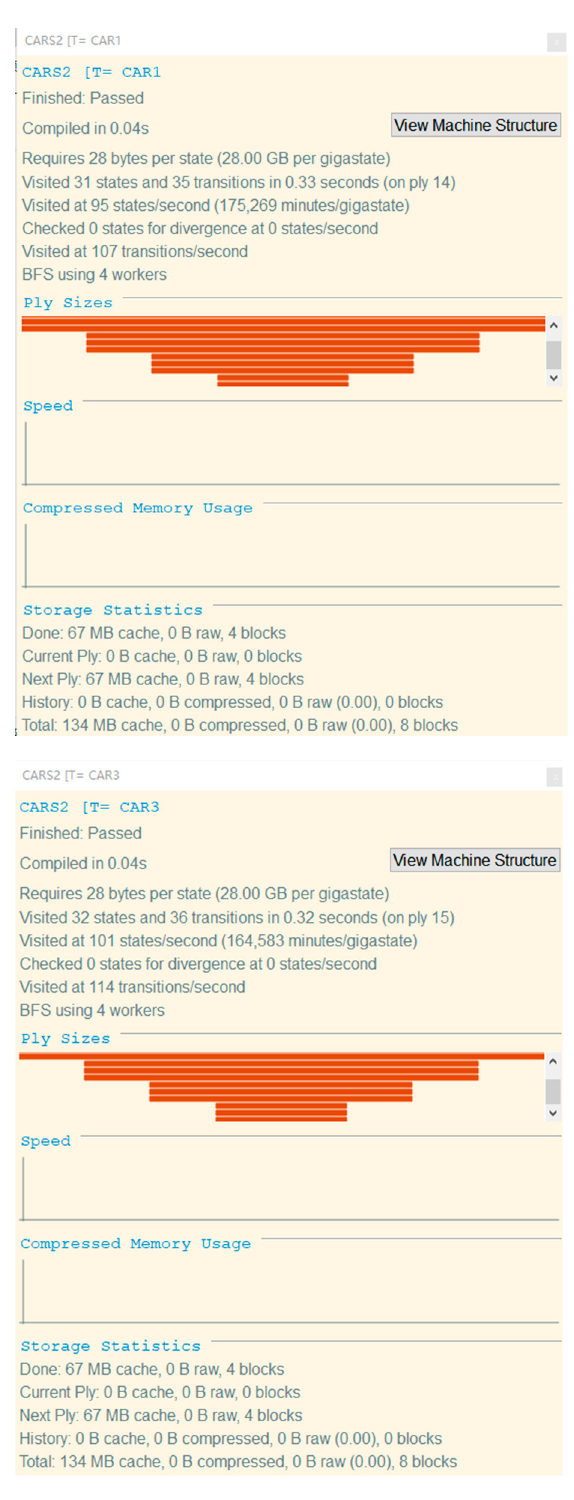
Figure 3. Safety inspection diagram.